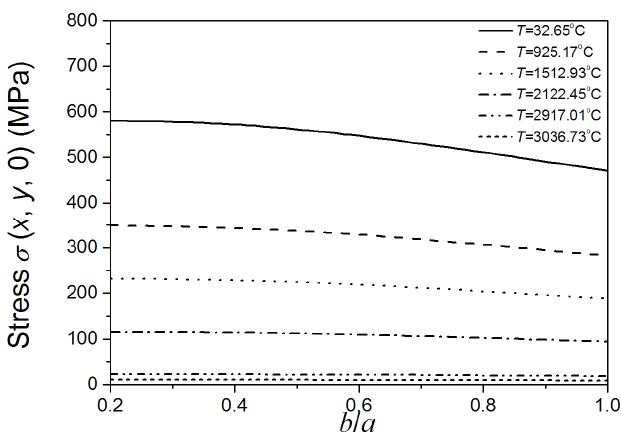
Figure 7. b / a ratio dependence of the highest σ ( x , y , 0) on the crack edge under different temperatures ( b is a definite value).